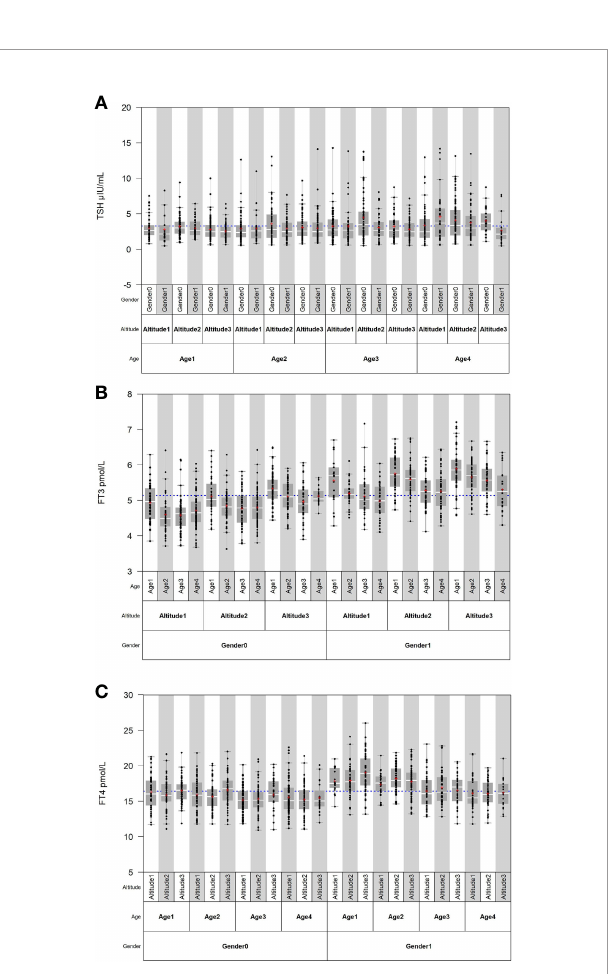
FIGURE 1 | Distribution of thyroid-related hormones in Tibetan population by sex, age, and altitude. (A – C) Distribution of TSH, FT3, and FT4 in Tibetan population by sex, age, and altitude.